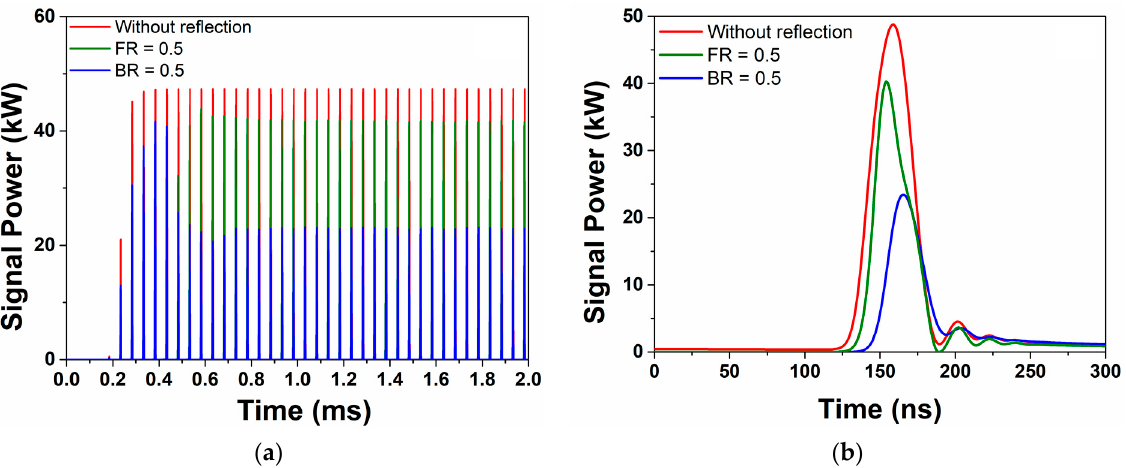
Figure 5. ( a ) The power evolution of the ampli fi ed pulsed signal sequence with and without re fl ec- tion. ( b ) The waveform of the ampli fi ed pulsed with and without re fl ection. The evolutions of the pulse waveform with di ff erent FR are analyzed and shown in Figure 6a. During the reduction of FR from 0.1 to 0.5, the peak power of the ampli fi ed pulse decreases by 7%, from 42.9 kW to 40.2 kW. The gain a tt enuation is proportional to the intensity of the re fl ection feedback. A stronger PW feedback light means a higher num- ber of upper-level population inversions being consumed. The pulse waveforms are nor- malized and magni fi ed in the time domain for comparison, as shown in Figure 6b. The insertion is the magni fi ed waveform near the pulse peak. The forward PW feedback makes the peak of the pulse appear earlier. The peak of the ampli fi ed pulse exceeds what is typ- ical by about 4 ns, and for every 20% increase in FR, the pulse peak moves forward by about 1 ns. The in fl uence of backward re fl ection on the evolution of the pulse waveform is analyzed in the same way. The backward-re fl ected feedback has the same e ff ect as the forward-re fl ected feedback on the gain of the ampli fi er, as is shown in Figure 7a. Back- ward re fl ection has more of an in fl uence on the gain than forward re fl ection. When the BR is 0.5, the peak power of the pulsed output is 23.4 kW, which is 16.8 kW lower than the peak power at FR = 0.5. This is mainly due to the stronger feedback signal power and the lower residual upper-level population inversion, which has been discussed above. The backward re fl ection feedback also has an obvious in fl uence on the waveform. The output pulse waveforms for di ff erent BR are normalized and compared in Figure 7b. The ex- panded waveform near the peak is plo tt ed in the insertion. The peak position is delayed by more than 3 ns compared with what is normal. The delay of the pulse peak is positively correlated with the BR feedback intensity. ( a )